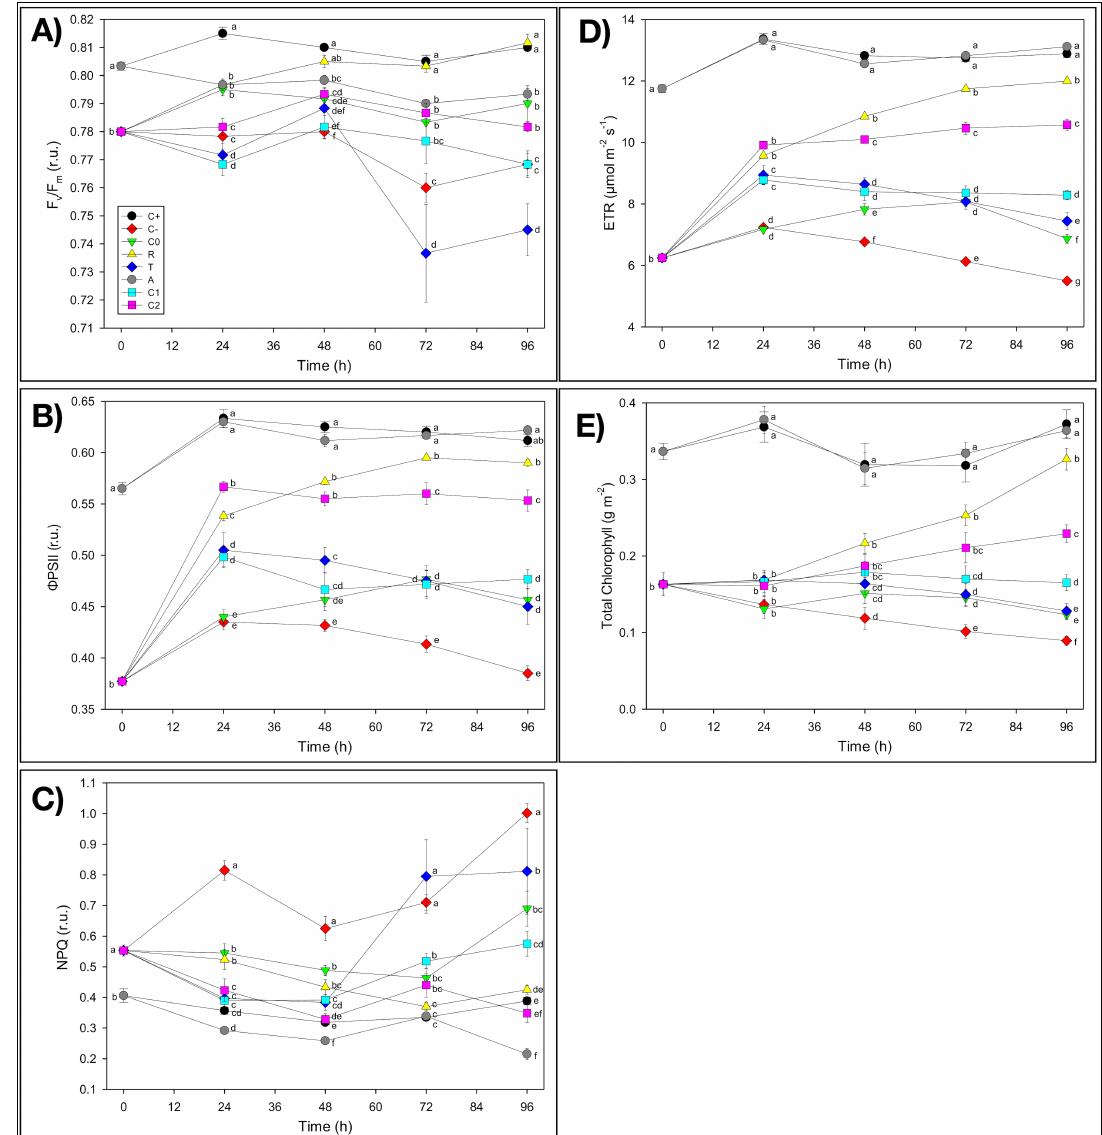
Figure 4. Quantitative analyses of the chlorophyll fluorescence parameters measured in Lemna minor fronds treated with different nutrient solutions and electrospun NMs over a 96 h incubation period: ( A ) F v /F m = maximum quantum yield of PSII photochemistry; ( B ) ΦPSII = quantum efficiency of PSII photochemistry; ( C ) NPQ = non-photochemical quenching; ( D ) electron transport rate ( ETR ); ( E ) total chlorophyll content. Check Section S2 in the SM for the explanation of acronyms here associated with graphical symbols as well as for the description of the various treatments and incubation details; and Section S3 for the description of the various parameters tested and procedures used to measure them. Black circle: C + ; Red diamond: C − ; Green triangle: C 0 ; Yellow triangle: R; Blue diamond: T; Grey circle: A; Cyan square: C 1 L-NMs (C 1 = 5 mM catechol); Pink square: C 2 L-NMs (C 2 = 100 mM catechol). Data points and vertical bars represent means (n = 6) ± S.E., respectively. One-way ANOVA was applied to each photosynthetic parameter; different letters indicate significant differences between treatments at each incubation period, according to the LSD test ( p ≤ 0.05).